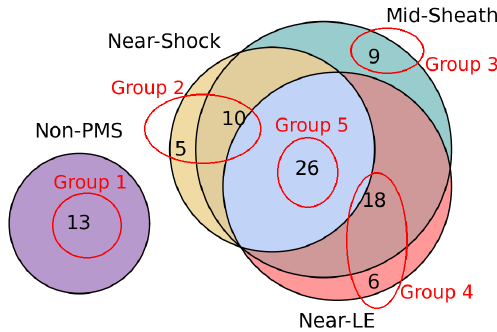
Figure 3. Distribution of the investigated sheath regions according to the presence and position of PMSs (for the explanation of differ- ent groups see Sect.